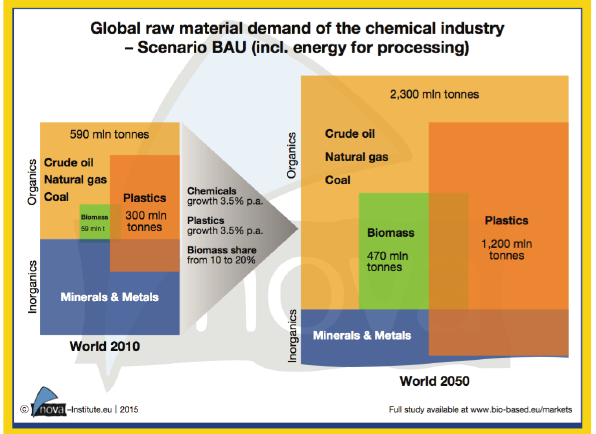
Figure 5: Global raw material demand of the chemical industry (scenario BAU, includes energy for